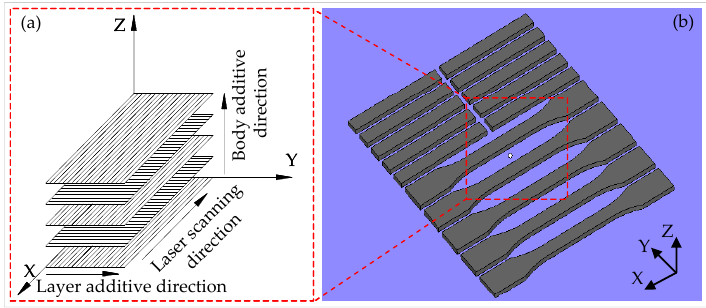
X axis of the equipment. To ensure that the sample was heated evenly, the sample was fixed in the middle of the sintering zone. The sintering method and the placement of the sample are shown in Figure 4. The processing parameters for SLS are shown in Table 2. Figure 4. The processing parameters for SLS are shown in Table 2.